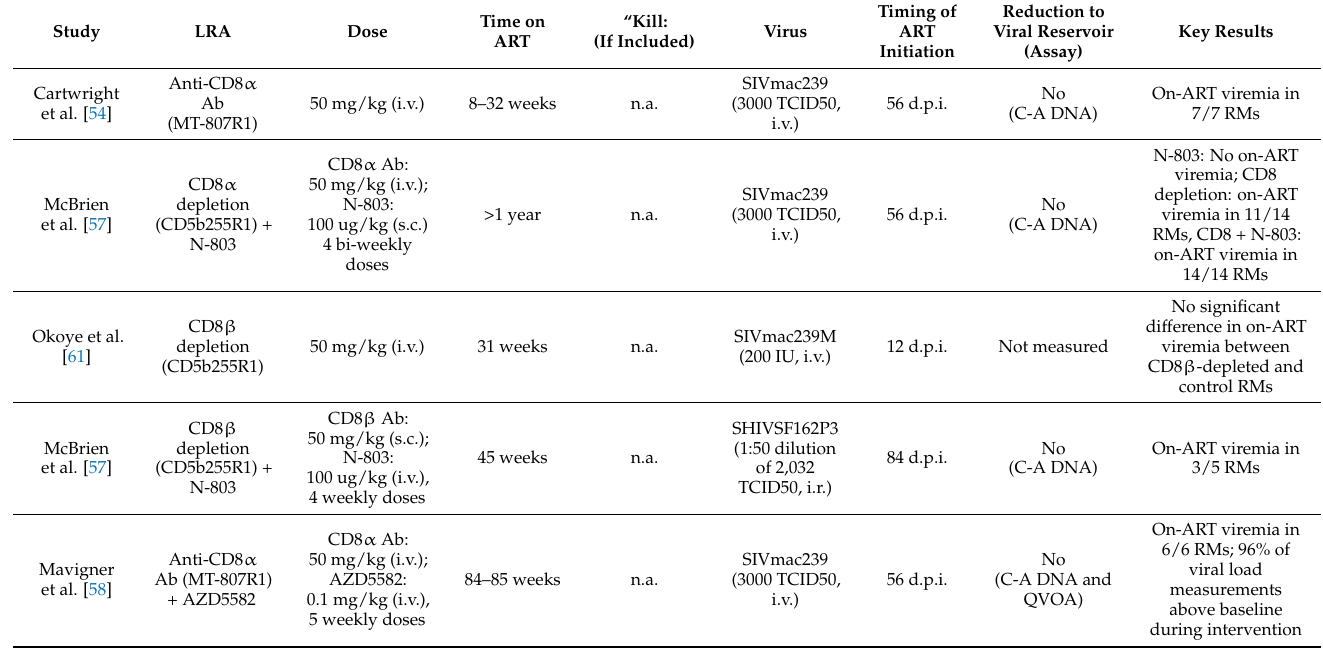
Table 2. Recent NHP studies testing CD8 depletion as an LRA. d.p.i., days post-infection; RM, rhesus macaque; i.v., intravenous, s.c., subcutaneous; TCID50, 50% tissue culture infectious dose; IU, infectious units; C-A, cell-associated; QVOA, quantitative viral outgrowth